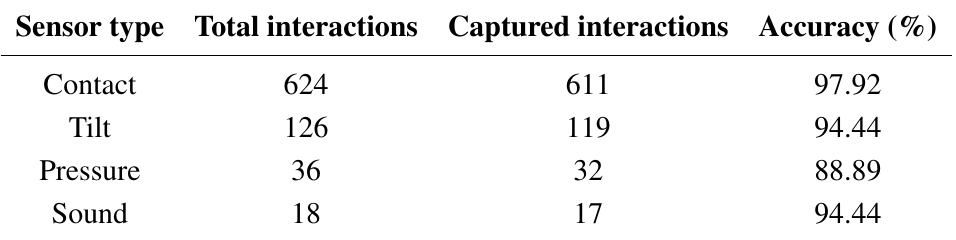
Table 1. Interaction recognition rate as shown by Chen et al .